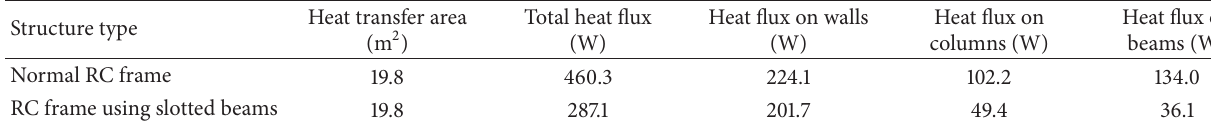
Table 10: Comparison of the FEM simulation results.